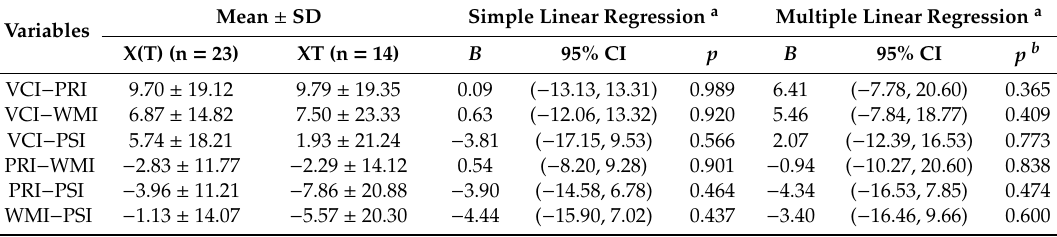
Table 5. Comparison of subtest-level discrepancy between the XT and X(T)